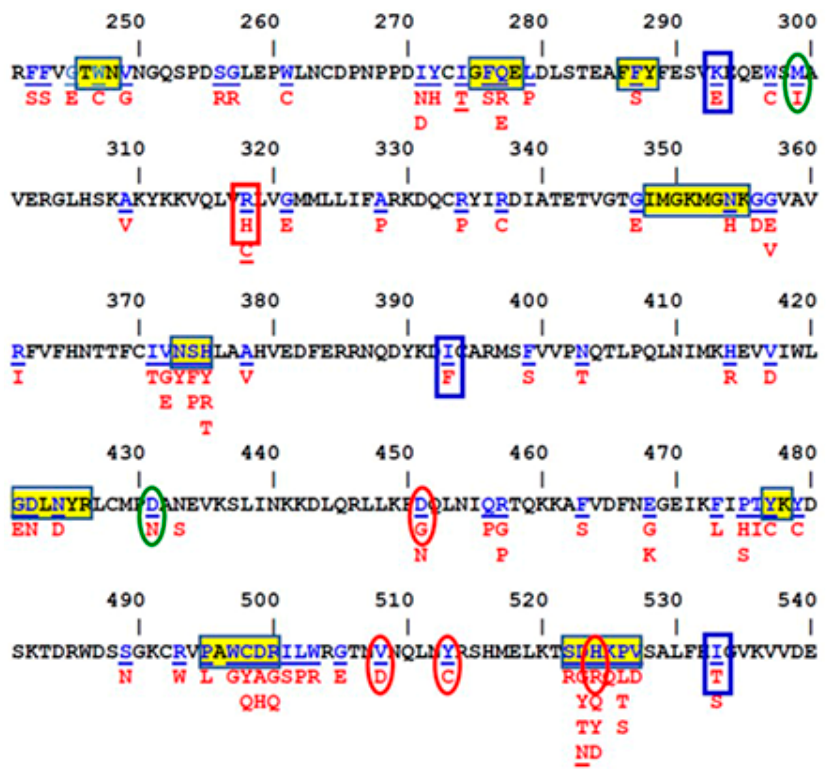
Figure 1. Missense changes a ff ecting OCRL1 ′ s phosphatase domain used in this study . The amino acid sequence of the OCRL1 phosphatase domain is shown with underlined blue residues to indicate those affected by missense mutations; amino acids resulting in such mutations are shown in red. Yellow rectangles enclose regions involved in processing/recognition of the substrate. Substitutions exhibited by variants used in this study are shown; those causing LS, D2, and LS/D2 are shown within red ovals, blue and red vertical rectangles, respectively; mutations with uncertain disease significance are shown within green ovals. Table 1. Selected OCRL1 Variants Used in This Study.